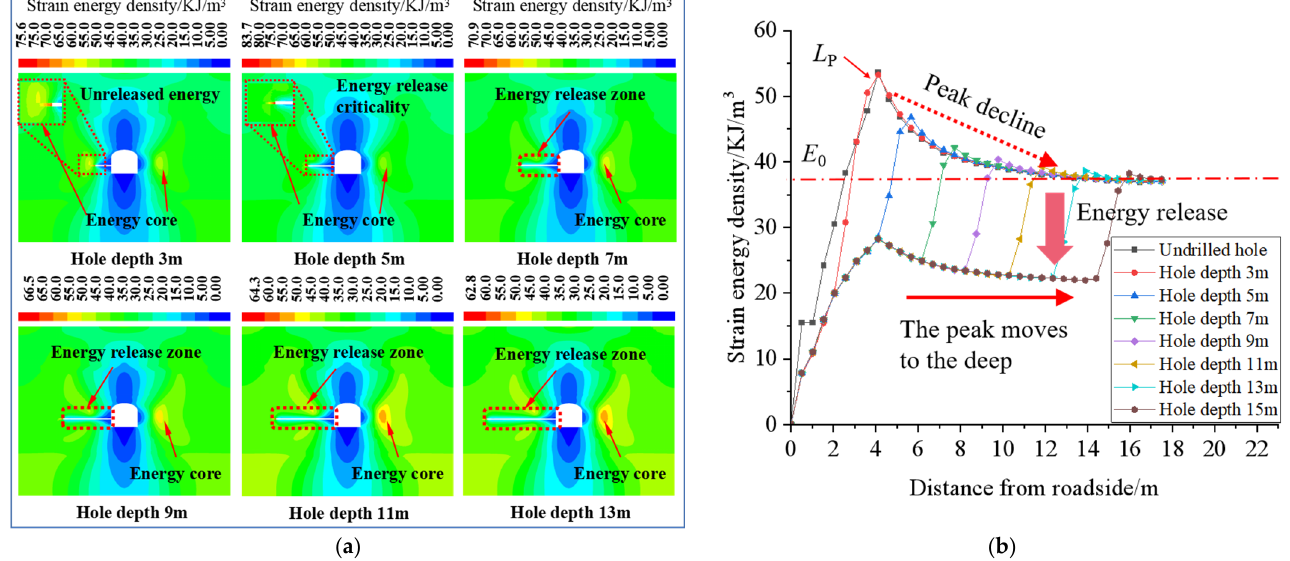
Figure 9. Energy release characteristics of the large-diameter borehole with different hole depths. ( a ) Evolution characteristics of the contour plot of strain energy density at different hole depths. ( b ) Evolution characteristics of the strain energy density curves with different hole depths.